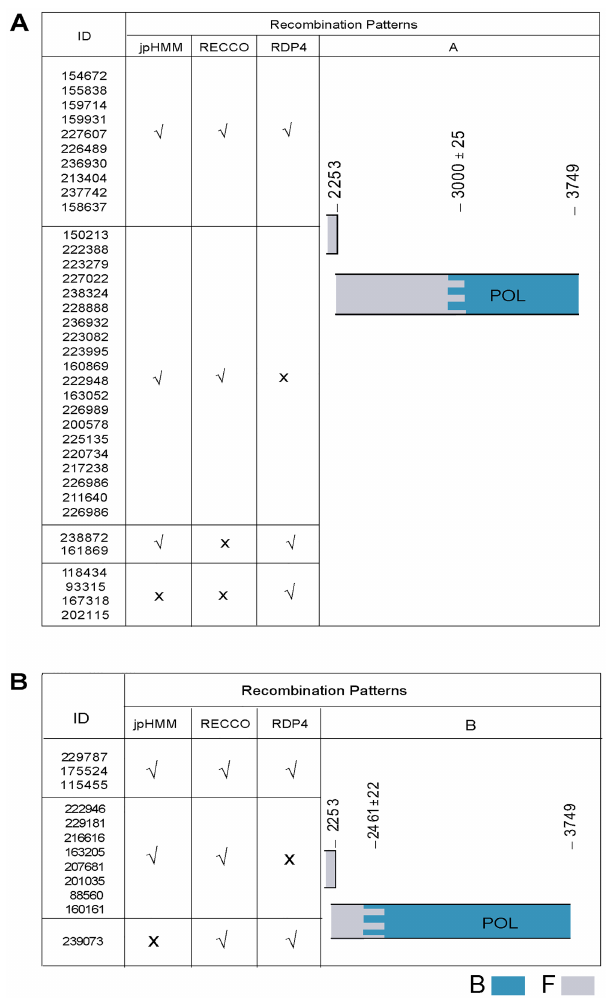
Fig 2. Predominant BF recombination patterns detected by different methods. Maps of BF recombinant geneticmosaic patterns (A and B) and breakpoint locationsat pol gene. Nucleotidesequencesnamed with p their ID are groupedaccordingto their concordance ( ) or discrepancy (X) in breakpointlocationsdefined accordingto the three in silico methods used (jpHMM, RECCO, and